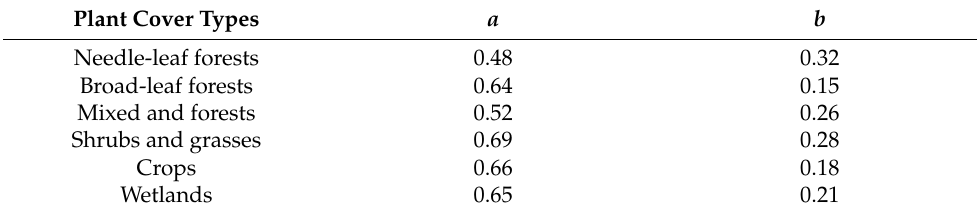
Table 1. Regression fitting coefficient values of six vegetation types.